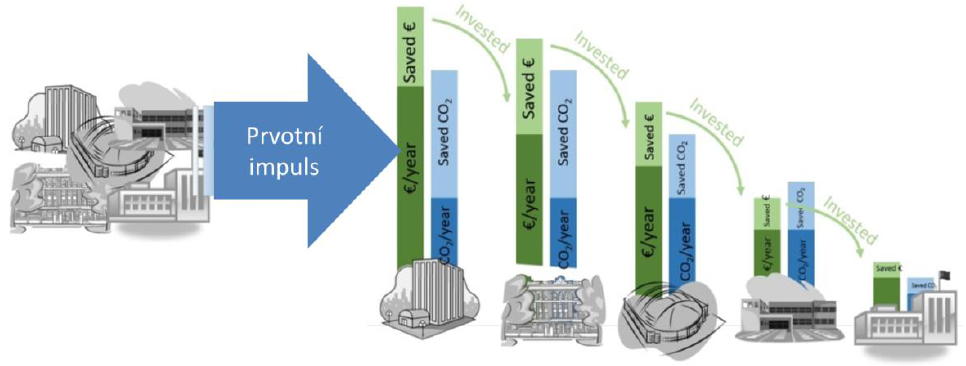
Figure 2: Schéma zavedení energetického managementu